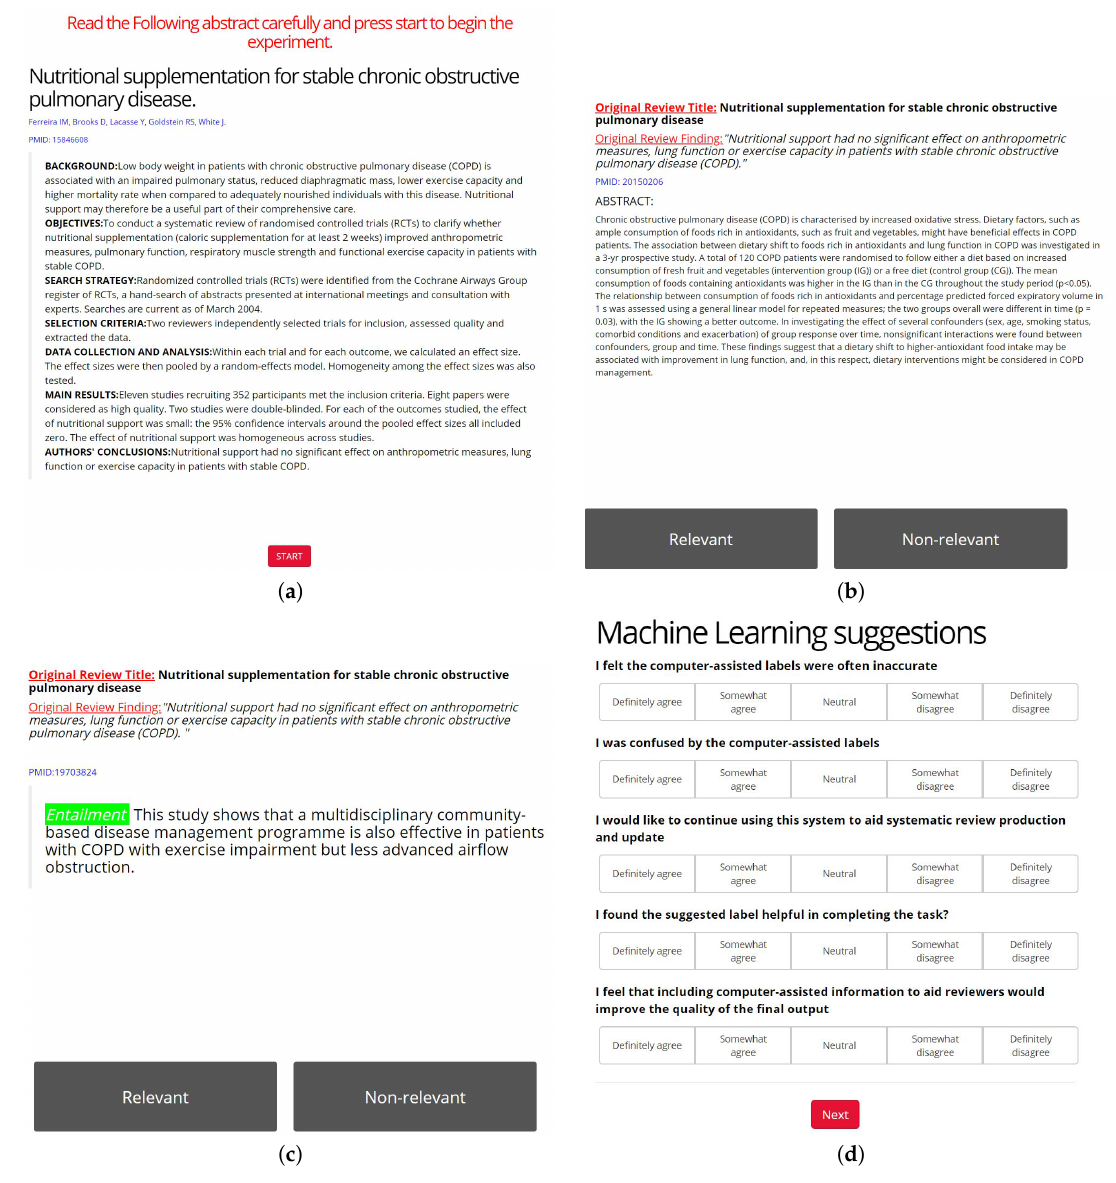
Figure 1. Screenshots of the user interface for both tasks and questionnaire in the experiment: ( a ) Original systematic review; ( b ) Abstract-View task; ( c ) Sentence-View task; and ( d ) Feedback